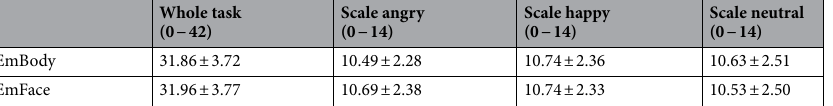
Table 2. Participant performance for the EmBody and the EmFace and their scales (mean ± SD ). Value ranges for all scales are reported in parentheses.